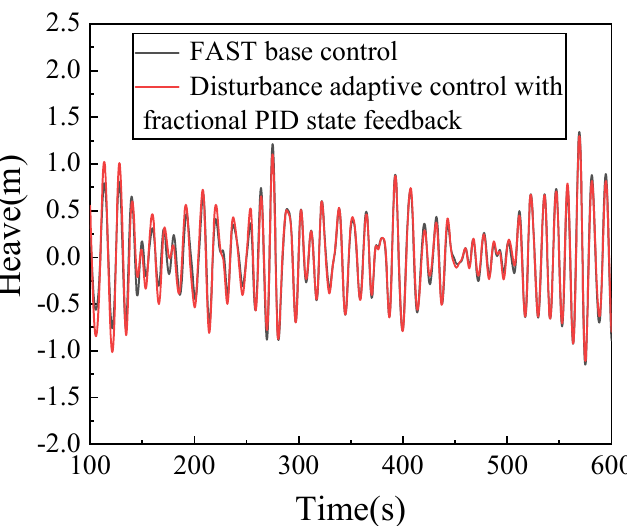
Figure 10. Comparison of pitch displacement under two different control algorithms.